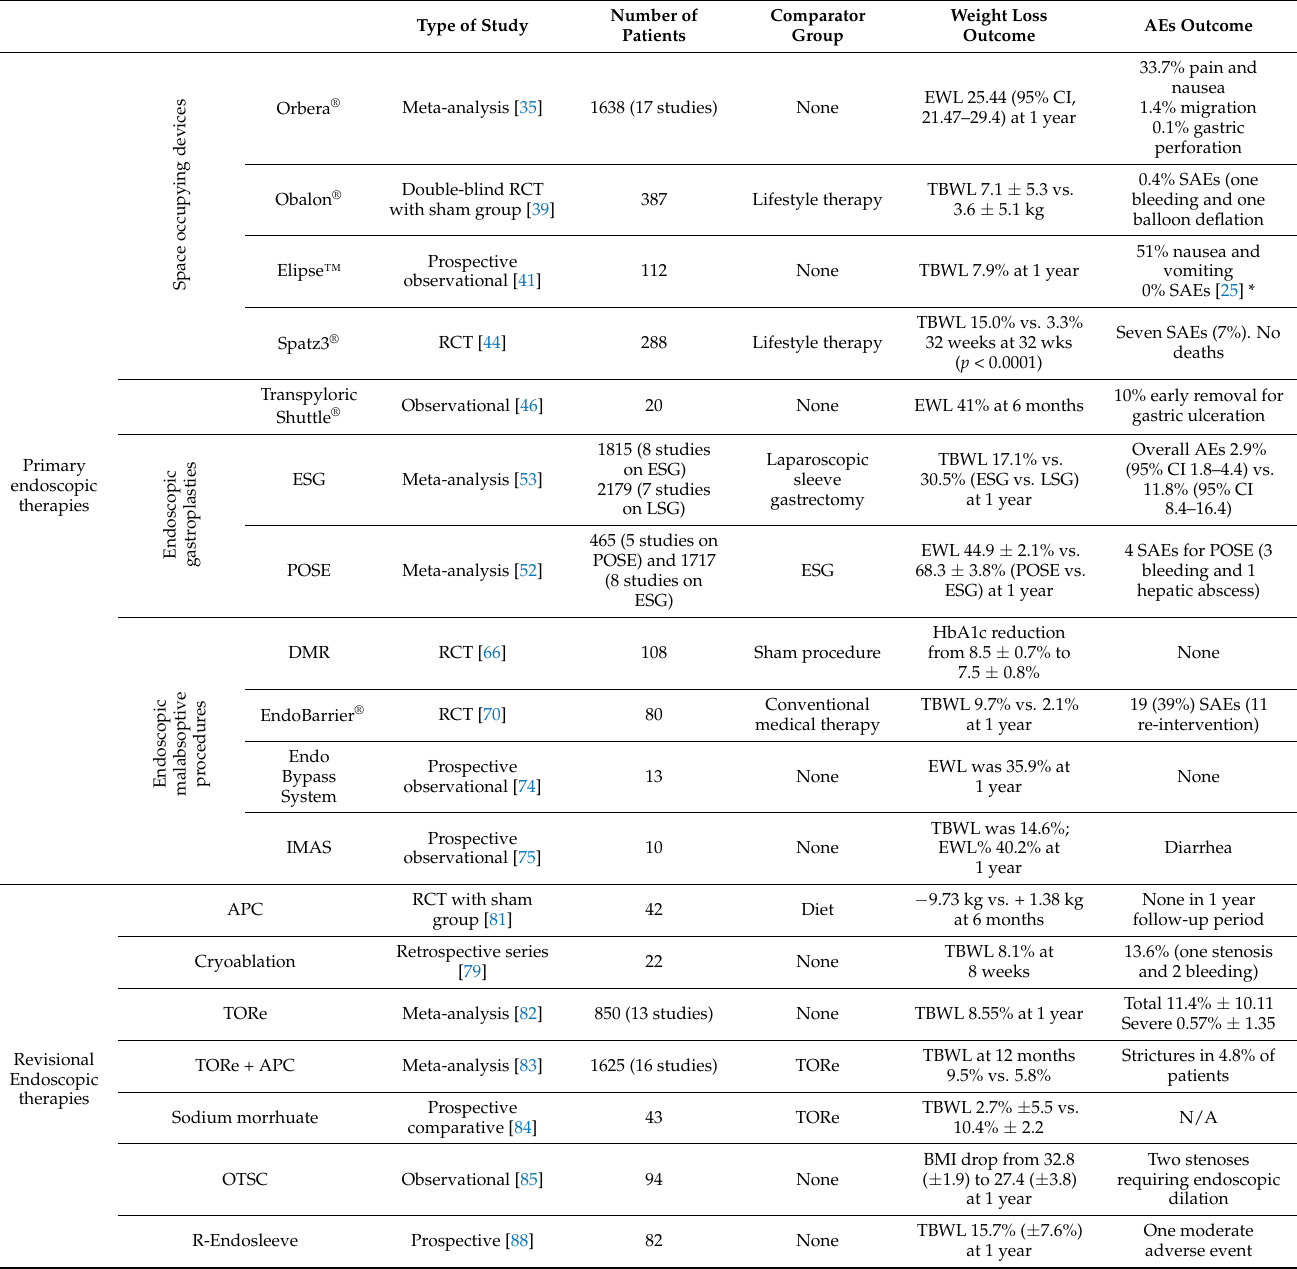
Table 1. Summary of the most relevant studies on the efficacy and safety of primary and revisional endoscopic